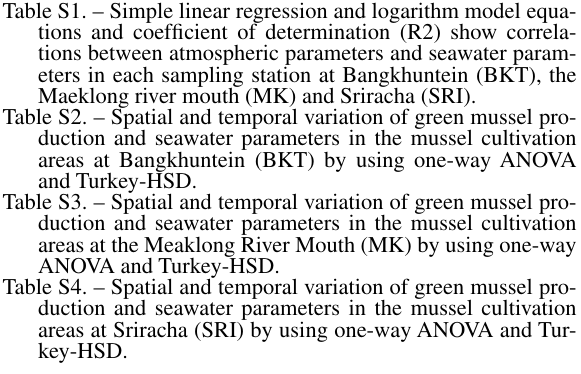
Table S1. – Simple linear regression and logarithm model equa- tions and coefficient of determination (R2) show correla-